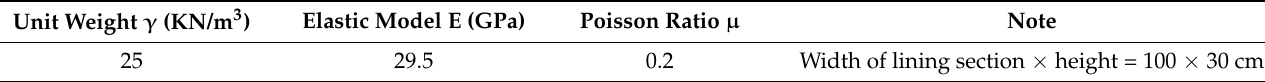
Table 2. Mechanical parameters of lining.